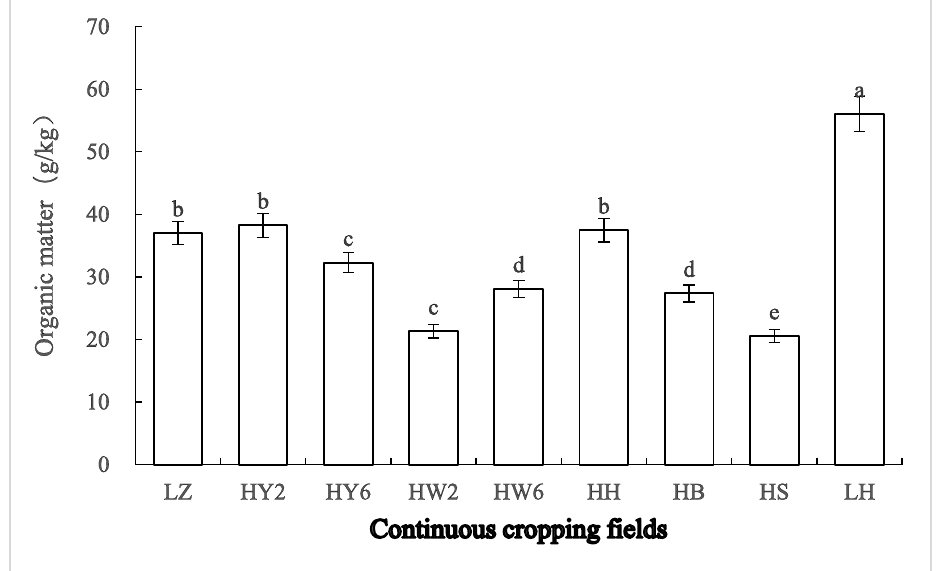
Figure 2. Content of organic matter under different continuous cropping and fallow fields. LZ, HY2, HY6, HW2, HW6, HH, HB, HS, and LH; continuous cropping of C. chinensis for 5 years, maize continuous cropping for 2 years, maize continuous cropping for 6 years, P. multiflorum continuous cropping for 2 years, P. multiflorum continuous cropping for 6 years, sweet potato continuous cropping for 2 years, F. thunbergia continuous cropping for 2 years, cabbage continuous cropping for 2 years, and fallow field, respectively. Different letters indicate significant differences between the fields ( p -Value <